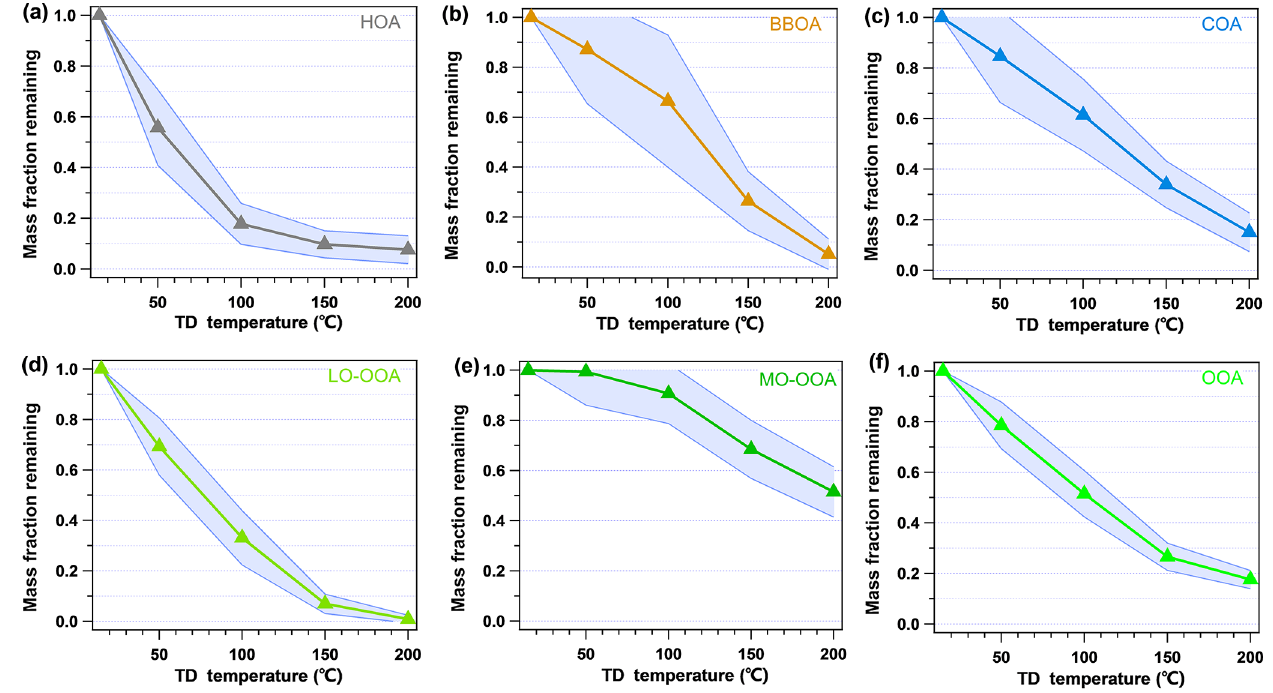
Figure 6. Average mass fraction remaining (MFR) of the five OA factors and OOA (calculated as the combination of MO-OOA and LO- OOA). The shaded region is the average MFR ± SD.